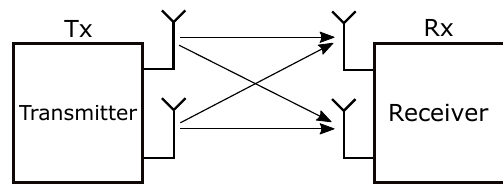
Figure 7. MIMO channel estimation testbed structure.